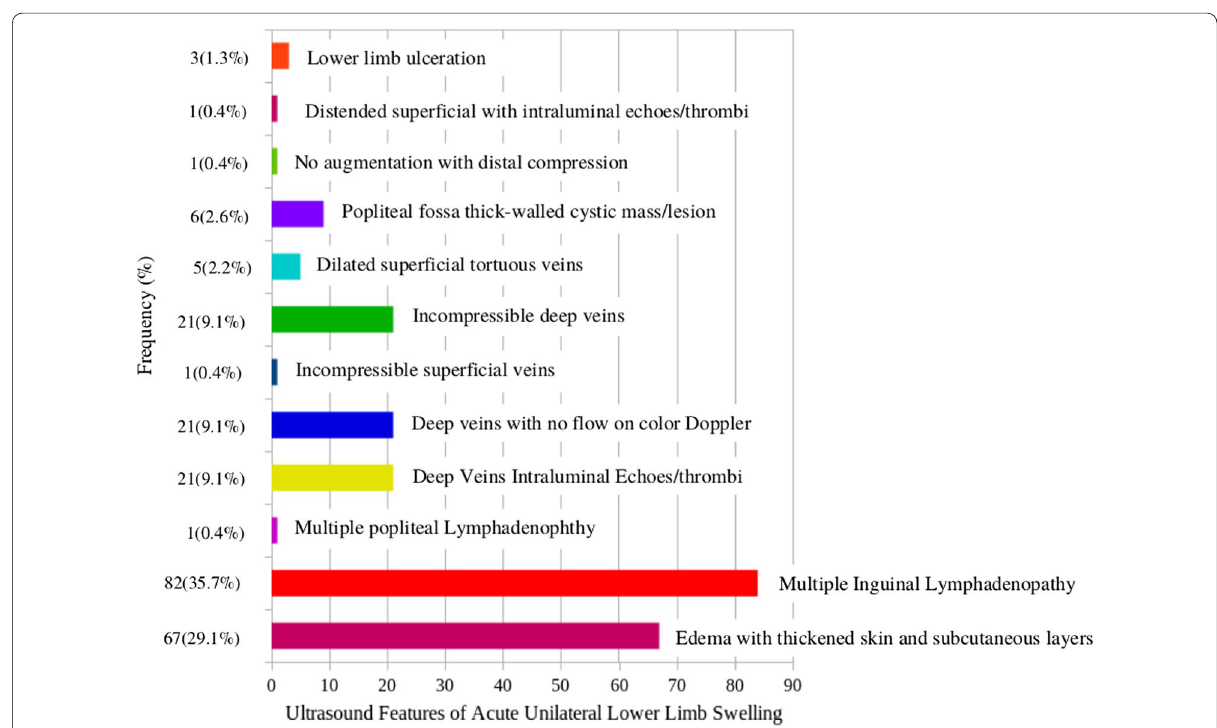
Fig. 3 Venous Doppler ultrasound features of patients with abnormal acute unilateral lower limb